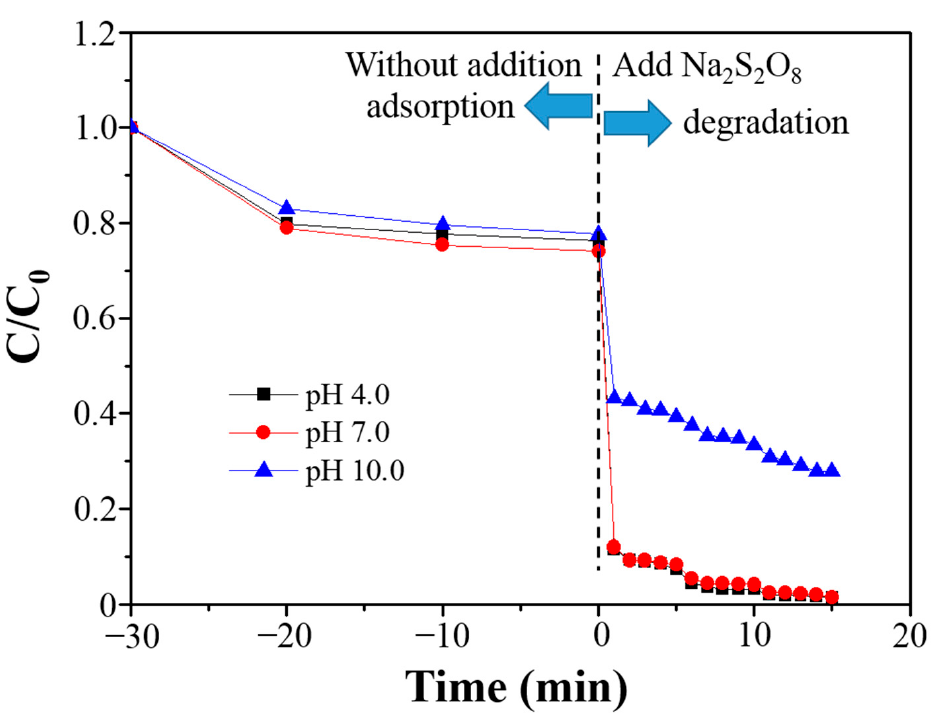
Figure 12. Fenton-like reaction for RhB degradation by the H-CuFeS 2 samples at different pH value system.